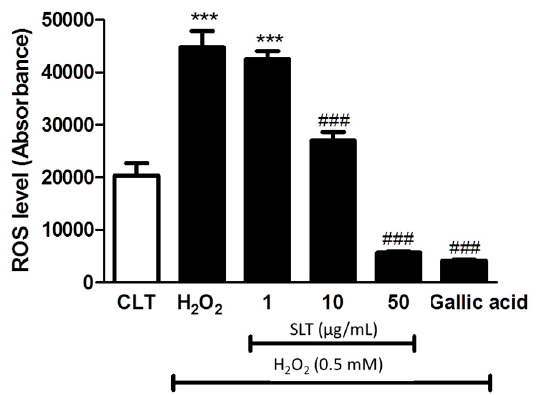
Figure 3. Effects of SLT (1–50 µg/mL) on H 2 O 2 -induced intracellular reactive oxygen species (ROS) generation in EA.hy926 cells. Gallic acid (10 µg/mL), a known potent anti-oxidant, was used as a positive control ( n = 3). Data are presented as means ± S.D. *** p < 0.05 vs. control group; ### p < 0.001 vs. H 2 O 2 group.